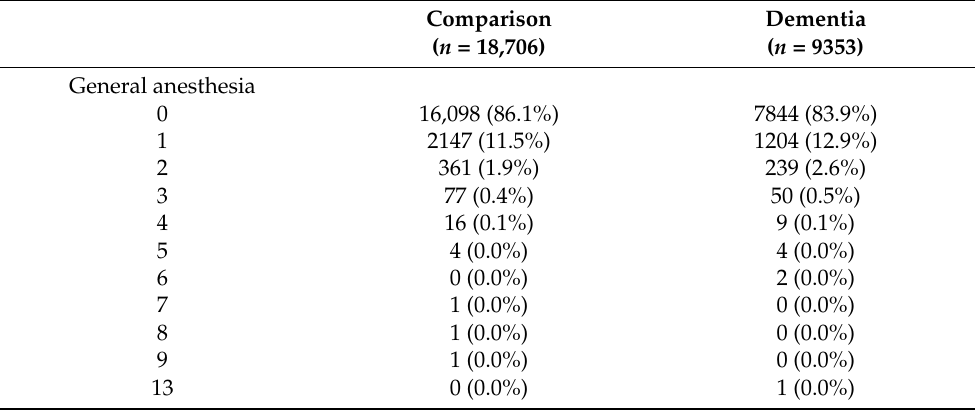
Table 6. Frequencies of general anesthesia between comparison and dementia